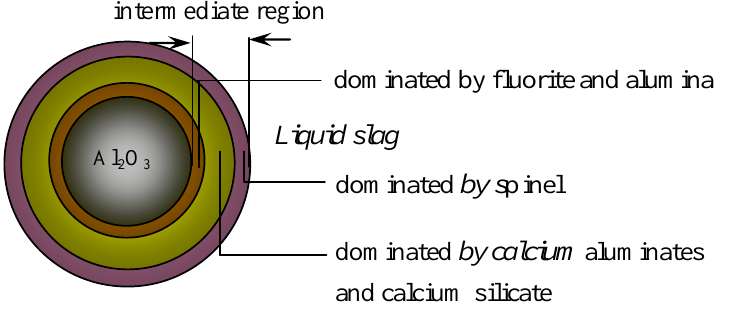
Figure 7. Dissolution mechanism of alumina inclusions in CaF 2 -Al 2 O 3 -CaO-MgO-SiO 2 slag.